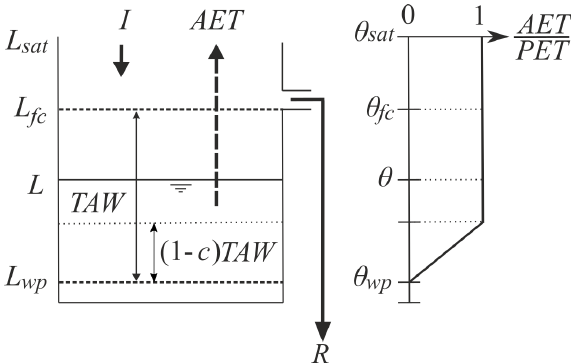
Figure 2. Schematic illustration of the unsaturated component. The right panel represents the variation in the ratio of potential to actual evapotranspiration in relation to the water content of the soil. The reader is referred to Sect. 2.3 and 2.4 for a detailed explanation of the terms shown